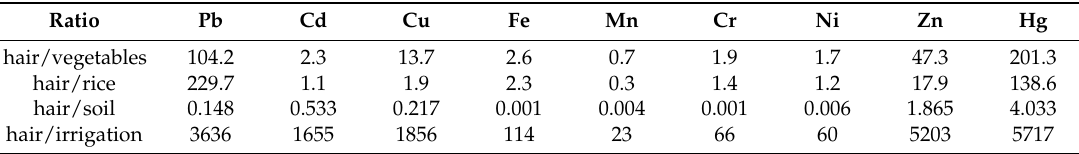
Table 10. Bioaccumulation factor (BAF) of metals between student’s hair, food and environmental